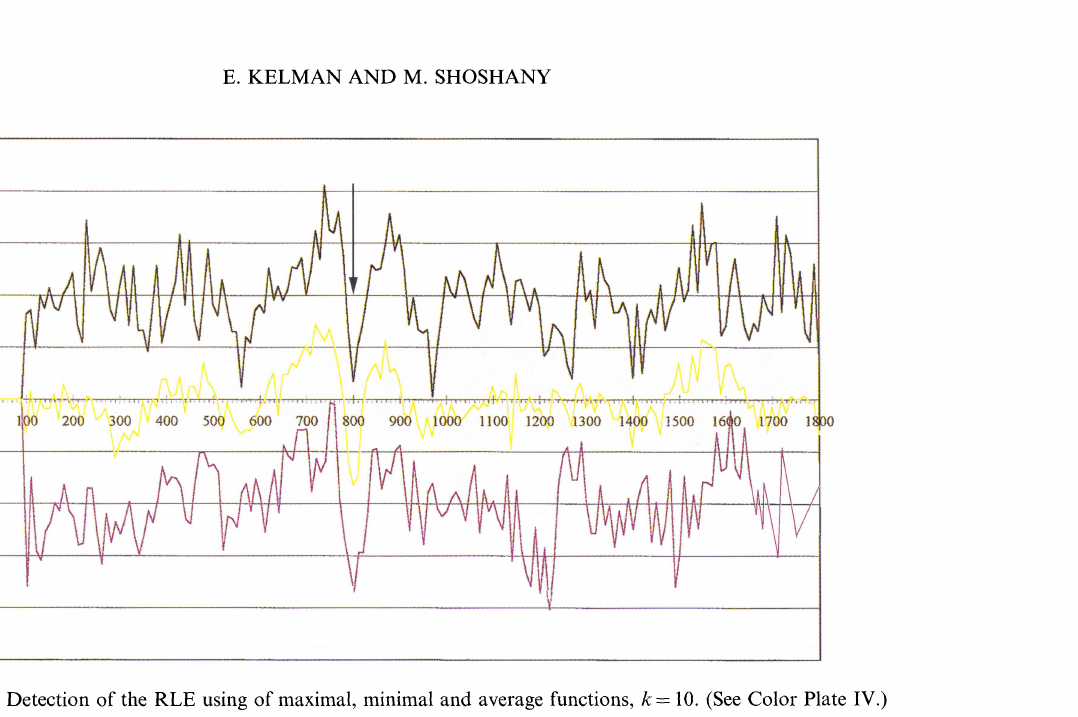
FIGURE 8 Detection of the RLE using of maximal, minimal and average functions, k 10. (See Color Plate IV.)